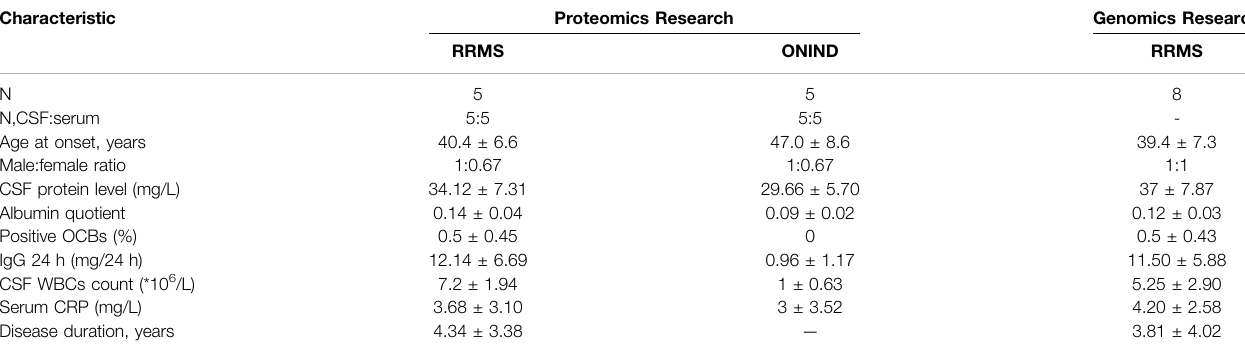
TABLE 1 | Demographic characteristic of the participants. Characteristic